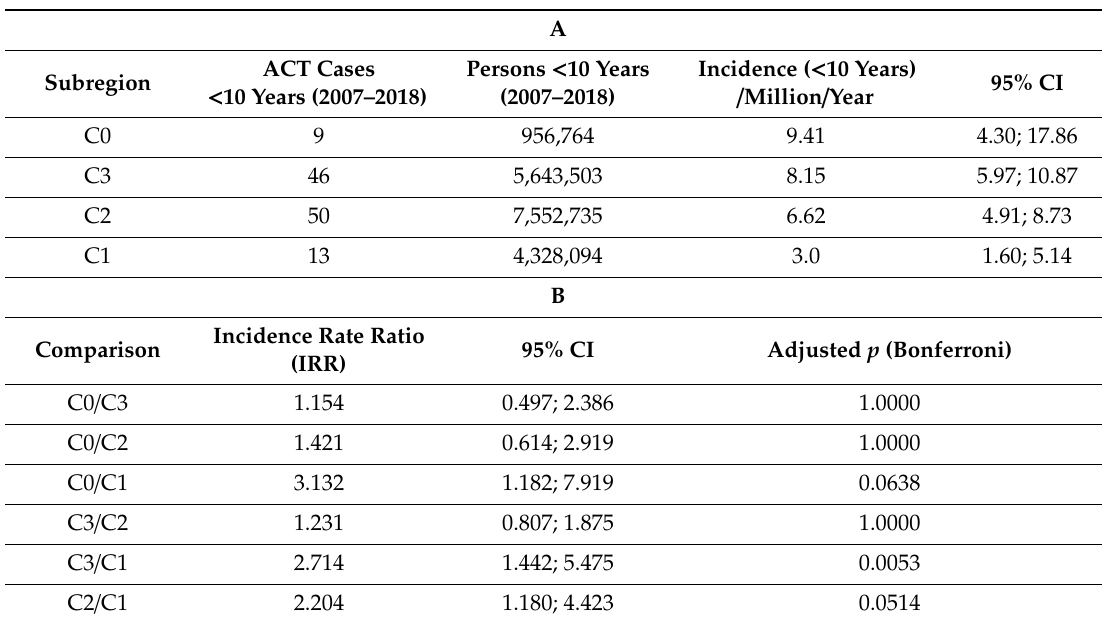
Table 2. ACT incidence rate per subregion of Paran á state ( A ), and di ff erences using Bonferroni adjusted p values ( B ) using the public databases